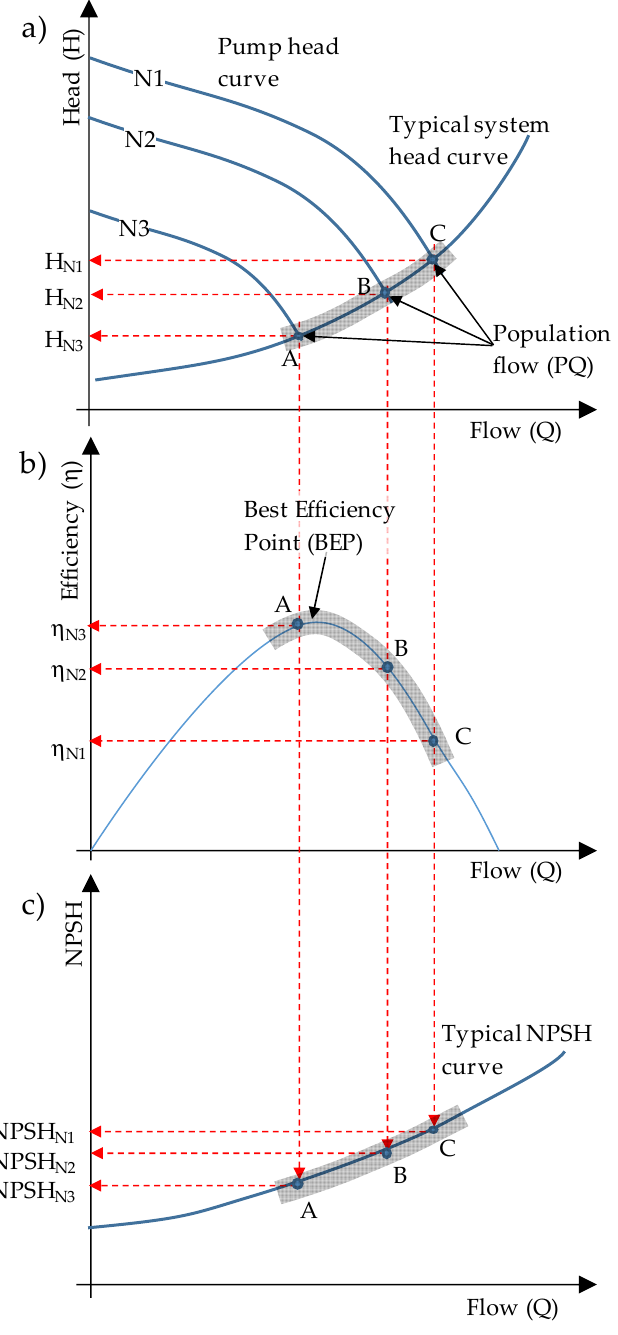
Figure 8. Operating range of centrifugal pump with VSD: ( a ) evolution of Head and Flow with the variable speed; ( b ) evolution of Efficiency and Flow with the variable speed; ( c ) evolution of NPSH and Flow with the variable